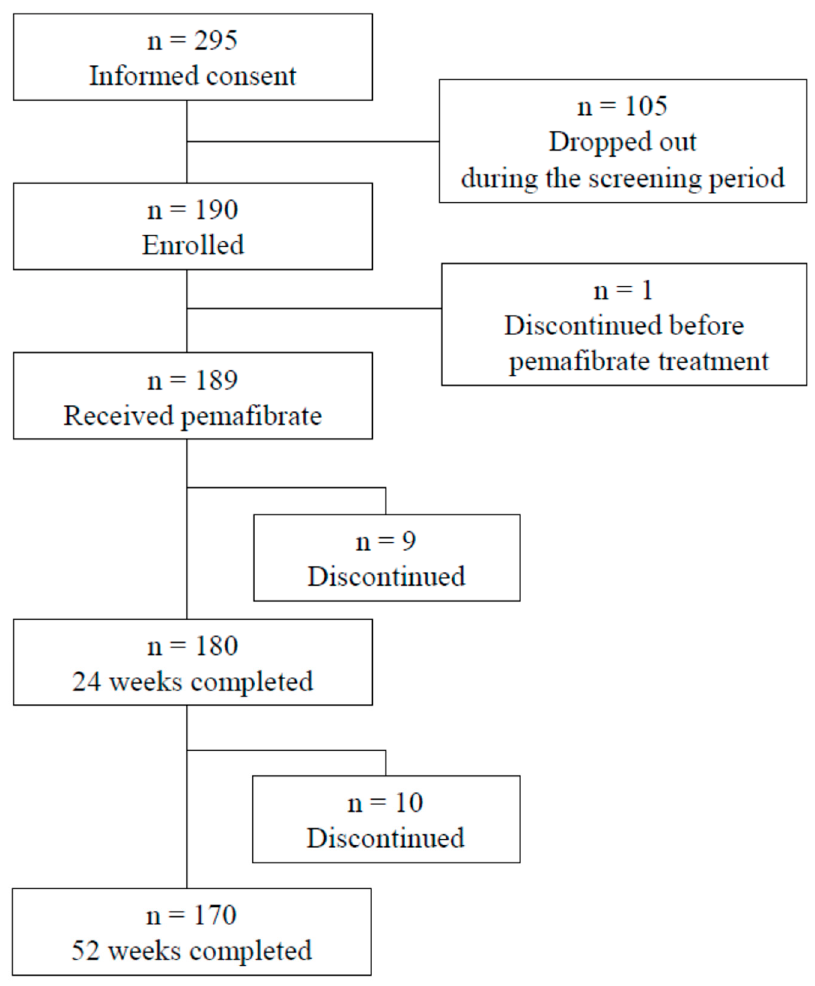
Figure 1. Flow chart of included and excluded patients.